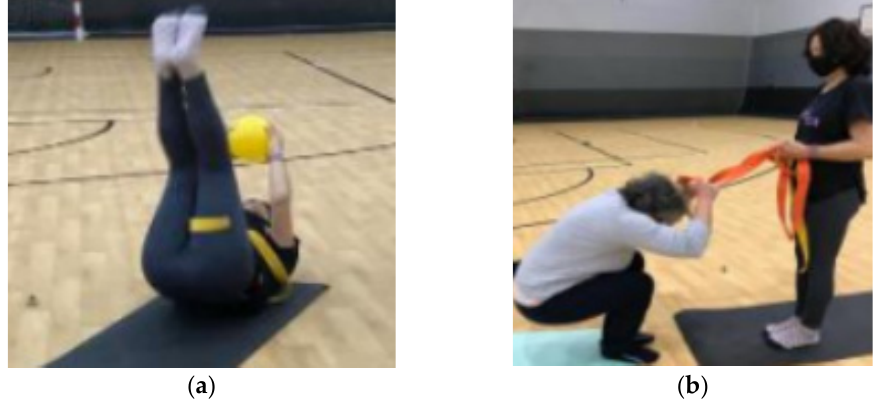
Figure 1. ( a ) Fall training with implements; ( b ) assisted falling